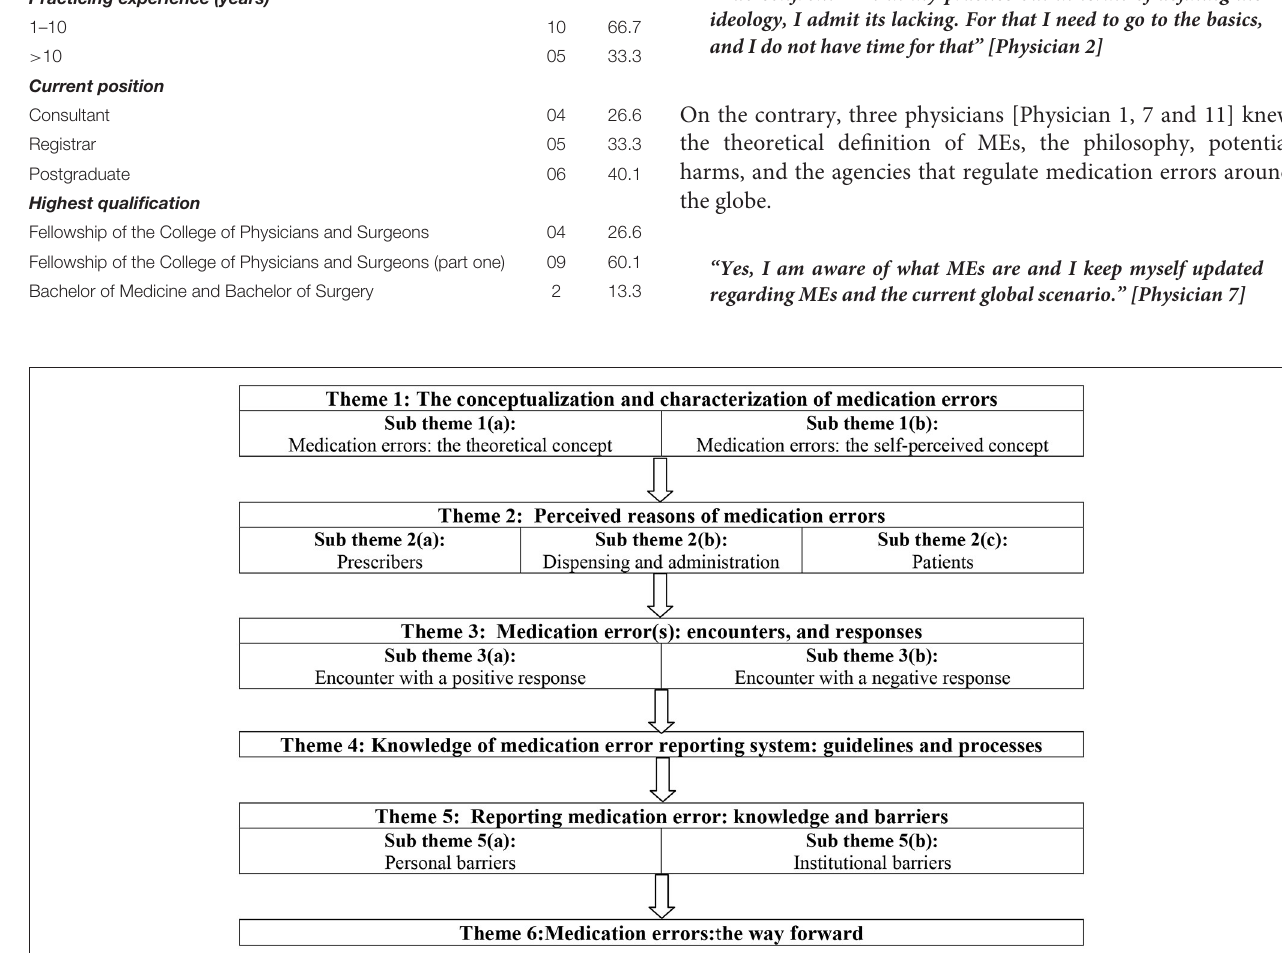
Frontiers in Medicine |